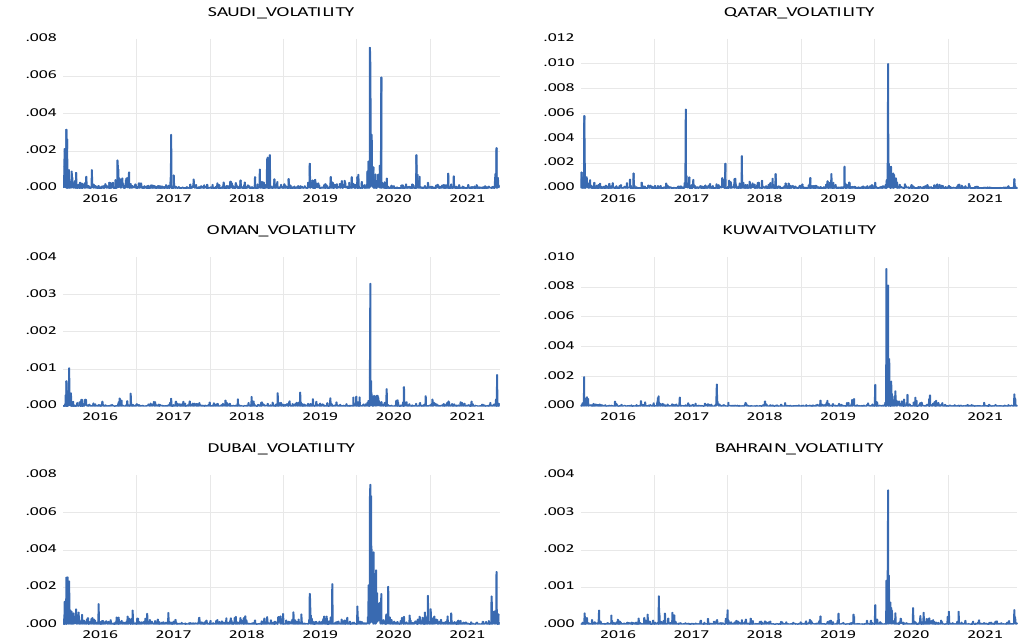
Figure 7. GCC volatility clustering (sources Data Stream). Table 11. GCC Volatility test.